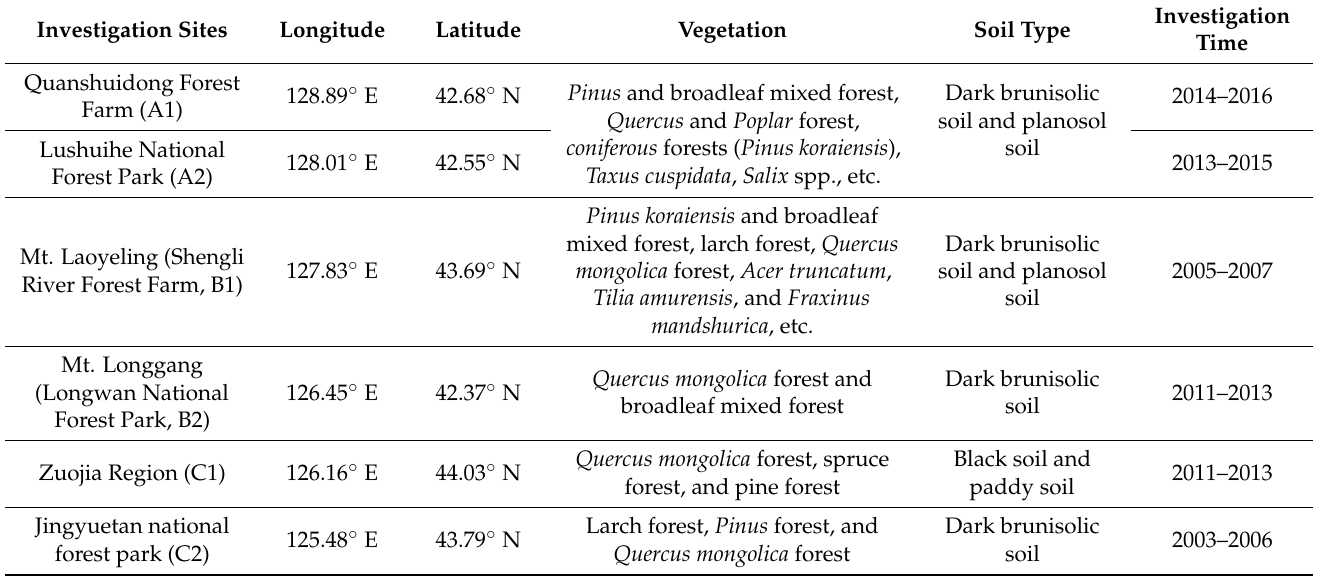
Table 1. Geographical coordinates and vegetation of the investigation sites.